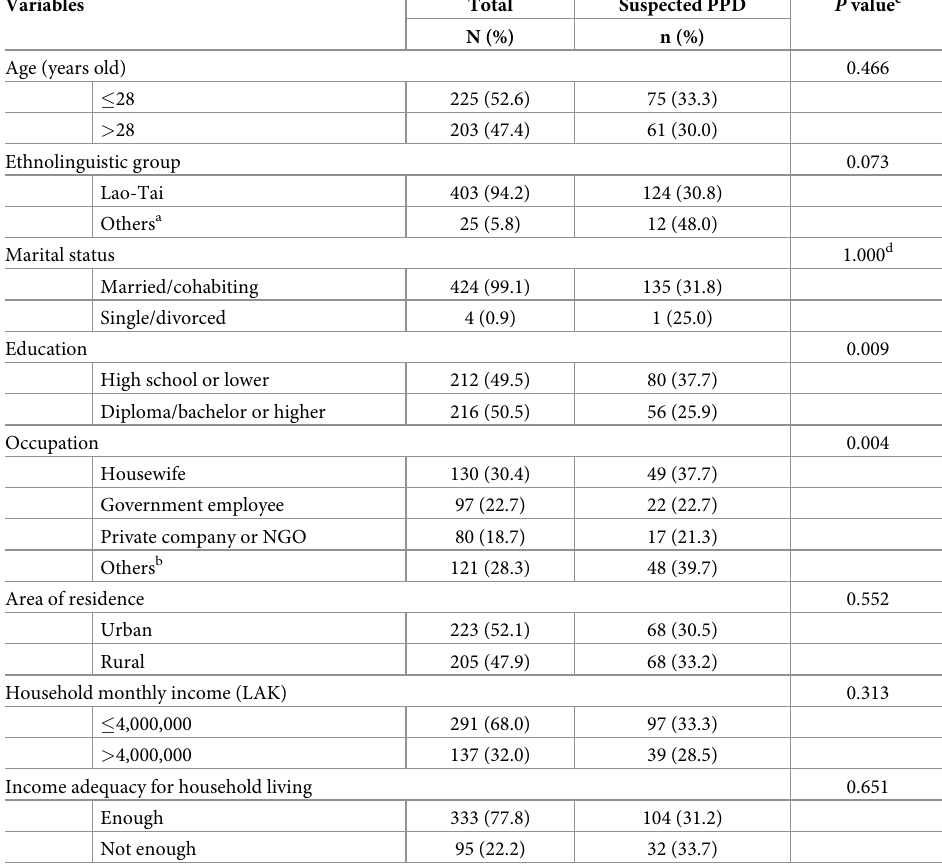
Table 1. Bivariate analysis of socio-demographic factors and suspected PPD among postpartum